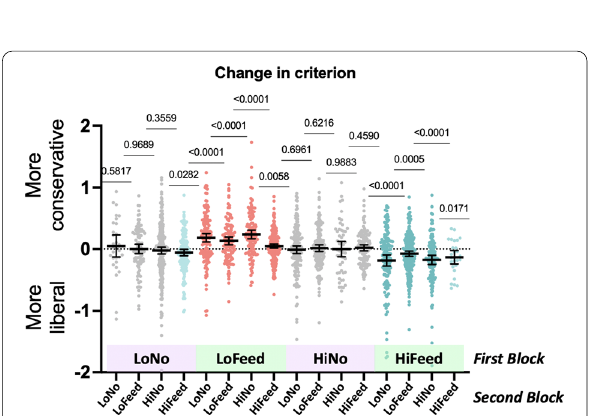
Fig. 5 Change in criterion on block 2 as a function of the nature of block 1. P values show results for simple t -tests, testing against the null hypothesis that there is no change in criterion. Black lines show means 95% confidence ±